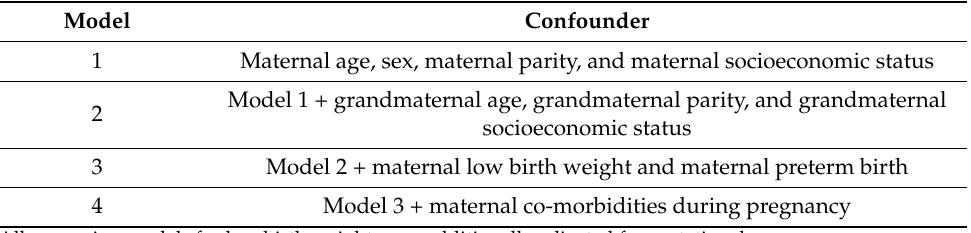
Table 2. Adjustment in regression models *.